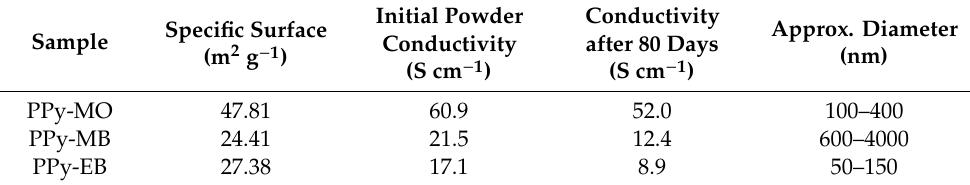
Table 1. BET measurements and DC electrical conductivity of PPy.